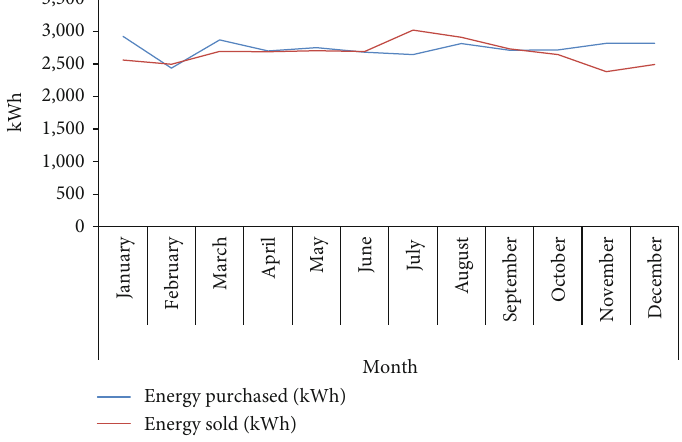
Figure 30: Grid sales and purchases for the grid-connected PV minigrid system without